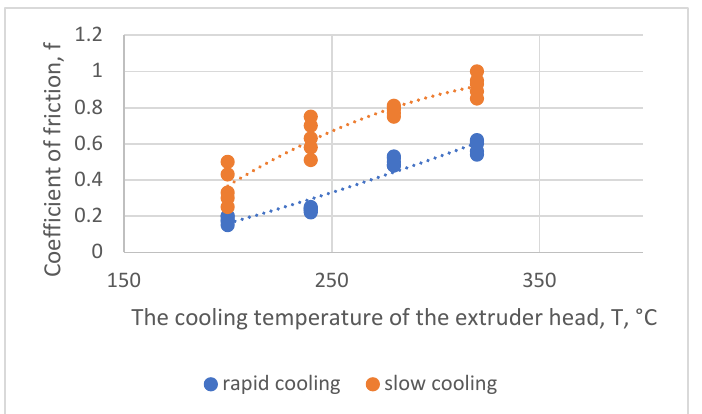
Figure 15. Dependence of the friction coefficient on the cooling temperature of the extruder head.